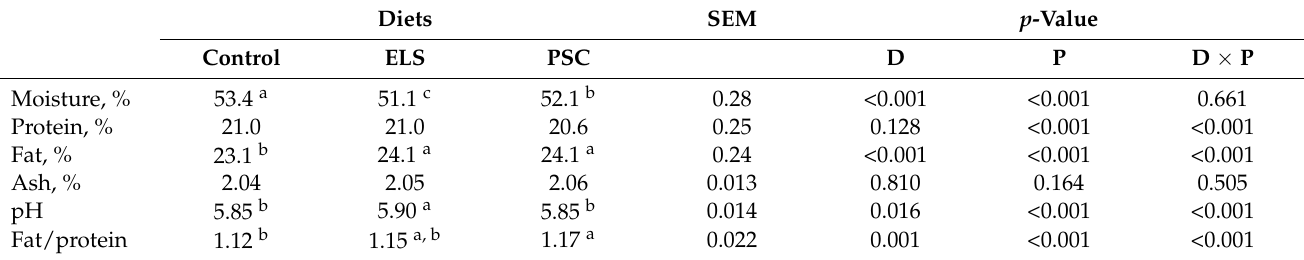
Table 2. Gross chemical composition of semi-hard cheese made of milk from goats fed with diets containing extruded linseed (ELS) or pumpkin seed cake (PSC).